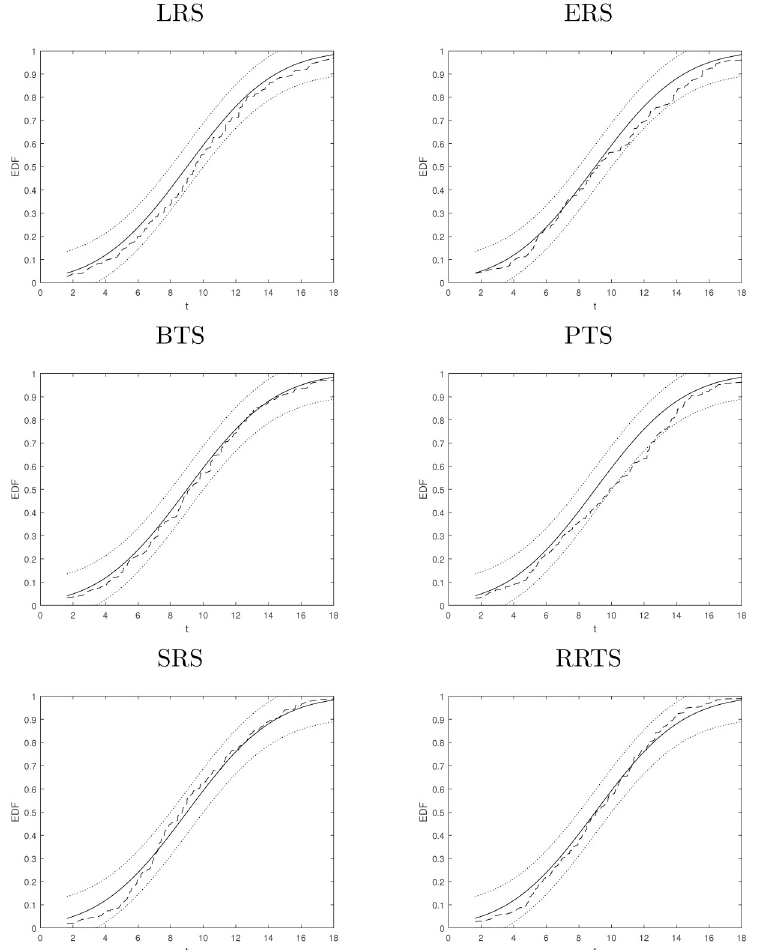
Fig 1. Comparison of roulete wheel sampling, based on